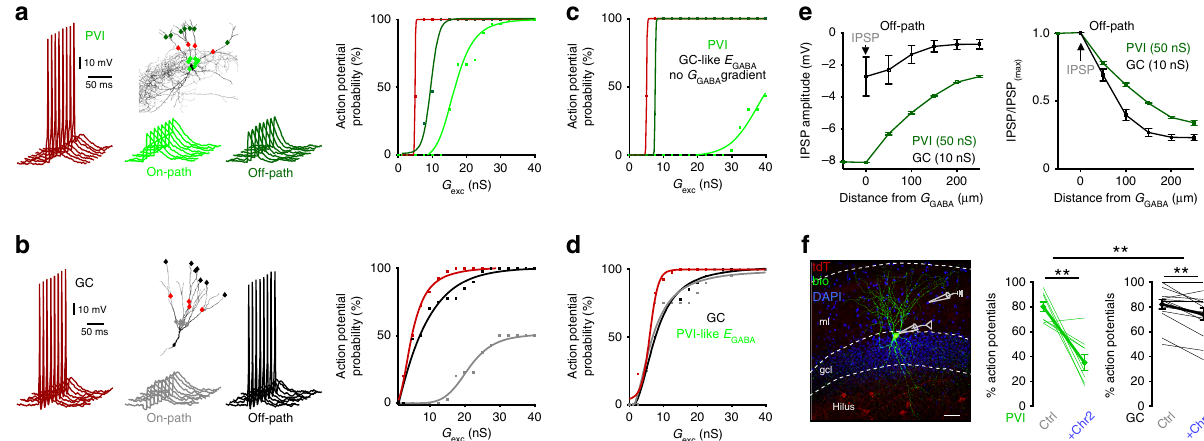
Fig. 7 Off-path inhibition controls action potential generation in PVI but not in GC models. a , b Action potentials in PVI and GC models were induced by excitatory conductances ( G exc ) activated at apical dendrites at 150 µ m distance to the soma (red circles) reproducing in vitro experiments (Fig. 4a, c). GABA A R-mediated conductances ( G GABA ) were initiated at seven dendritic sites located either on- or off-path in relation to the G exc site (14 and 54 nS in three PVI models, 7.5 and 7.5 nS in four GC models, for on- and off-path inhibition, respectively). Left traces, subsequently evoked individual action potentials (red) in a PVI (upper) and a GC (lower). Middle, voltage traces resulting from the interaction between excitatory signals and on-path inhibition in PVI (upper, bright green) and GC models (lower, gray). Right traces, same as middle but for off-path inhibition. Right graphs, probability of action potential generation plotted as a function of G exc without inhibition (red) and in presence of on-path (PVIs, light green; GCs, gray) or off-path inhibition (PVIs, dark green; GCs, black). Data were fi t with a sigmoid function. c , d Discharge probability was plotted against G exc for PVIs (upper), equipped with GC-like E GABA and with constant G GABA , and for GCs ( d ), equipped with a PVI-like E GABA gradient, in control conditions (red) and during on- (gray) or off- path (black) inhibition. e Left, an inhibitory input was placed at a distance of 250 µ m from the soma in PVI and GC models. IPSP amplitude along the dendrite is plotted against distance from its induction site (arrow). Right, IPSP amplitudes at different dendritic locations were normalized to the maximum amplitude at their induction site and plotted against distance from the G GABA location. f Left, representative confocal stack of a biocytin- fi lled PVI in an acute slice from a SOM-Cre mouse expressing channelrhodopsin-2 (Chr2) and tdTomato (tdT) after viral injection (scale bar 50 µ m). Single action potentials were evoked by extracellular perforant path stimulation and the effect of a short overlapping Chr2 pulse on action potential probability is plotted for PVIs and GCs. Squares and circles represent means and lines depict ±s.e.m. Thin lines in panel ( f ) represent individual experiments. ** p ≤